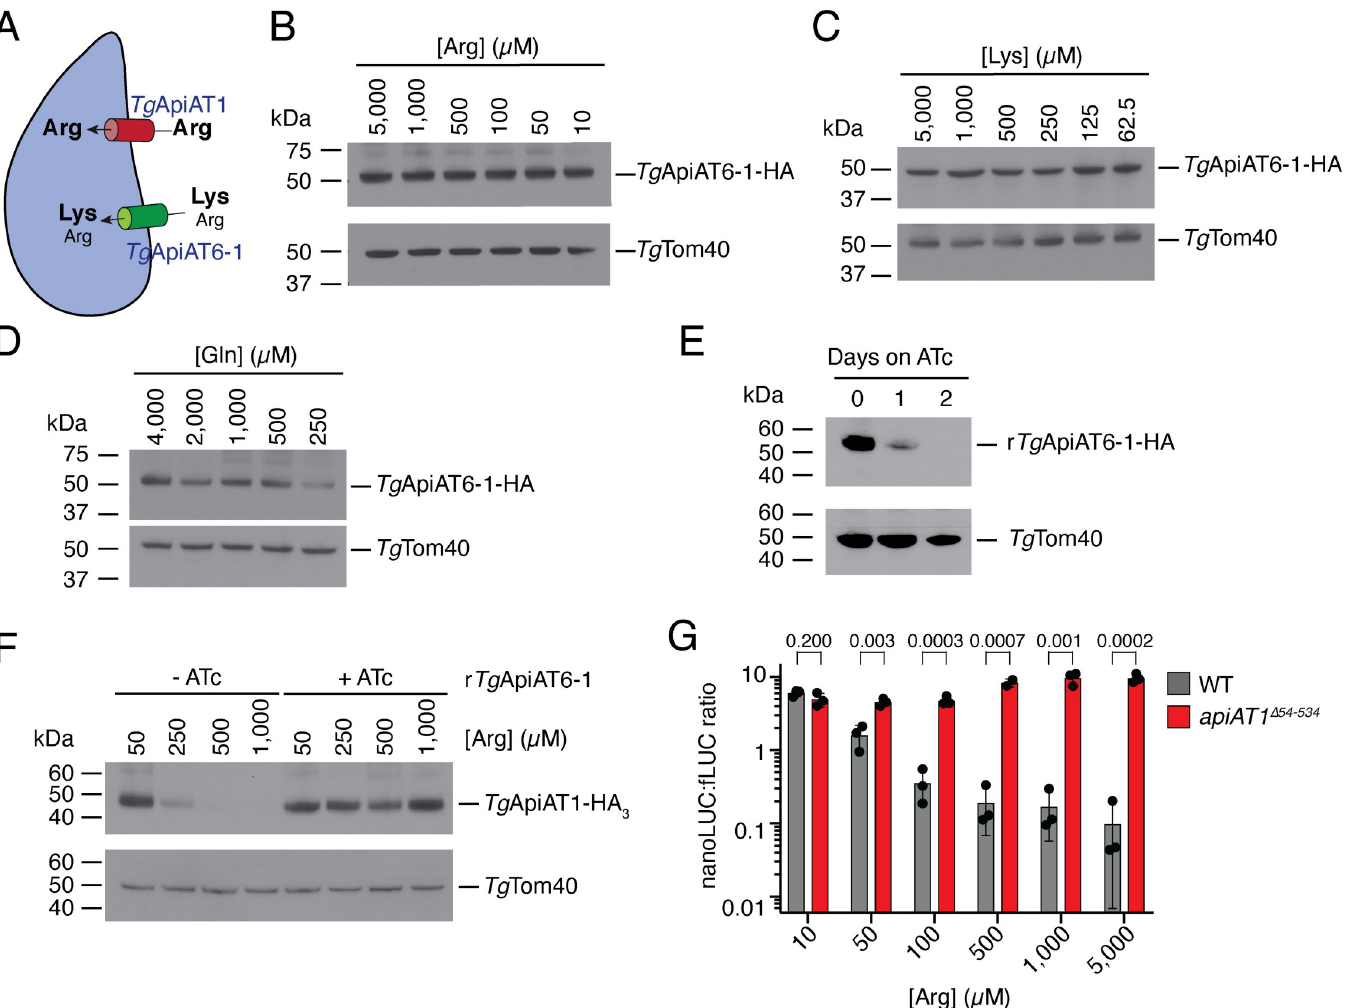
Fig 4. Tg ApiAT1 regulation is dependent on transporter-mediated uptake of Arg and Lys into the parasite. ( A ) Model of Arg uptake by T . gondii . Tg ApiAT1 is a selective Arg transporter, while Tg ApiAT6-1 is a cationic amino acid transporter with a high affinity for Lys and a lower affinity for Arg. ( B-D ) Western blots measuring the abundance of Tg ApiAT6-1-HA-expressing parasites grown at a range of ( B ) [Arg], ( C ) [Lys], or ( D ) [Gln] in the growth medium. Tg Tom40 is a loading control. Data are representative of that from two independent experiments. ( E ) Western blot measuring the abundance of r Tg ApiAT6-1-HA 3 upon the addition ATc for 0 to 2 days. Tg Tom40 is a loading control. Data are representative of three independent experiments. ( F ) Western blot of Tg ApiAT1-HA 3 in r Tg ApiAT6-1 parasites grown in the absence or presence of ATc, and at a range of [Arg] in the growth medium. Tg Tom40 is a loading control. Western blots are representative of three independent experiments. ( G ) nanoLUC:fLUC ratios in WT and apiAT1 Δ 54–534 parasites expressing nanoLUC from the Tg ApiAT1 5’ region and fLUC from the α -tubulin 5’ region, and cultured at a range of [Arg]. Data represent the mean ± SD from two or three independent experiments. P values were calculated using unpaired t-tests, not assuming equal variance (d.f. = 4). Note that the data from the WT experiments were also included in replicates for the data shown in Fig